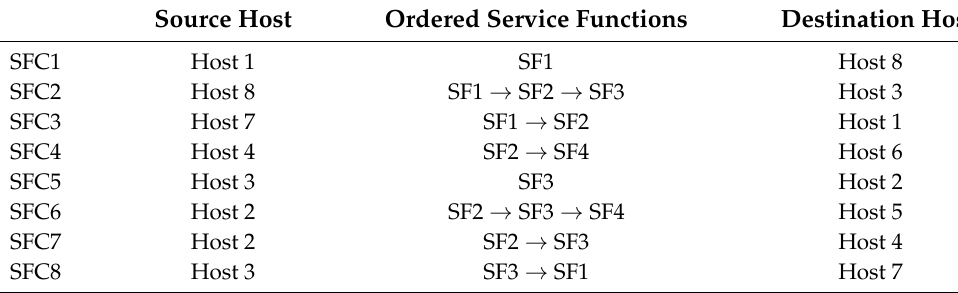
Table 1. Details of the configured SFC in the emulated